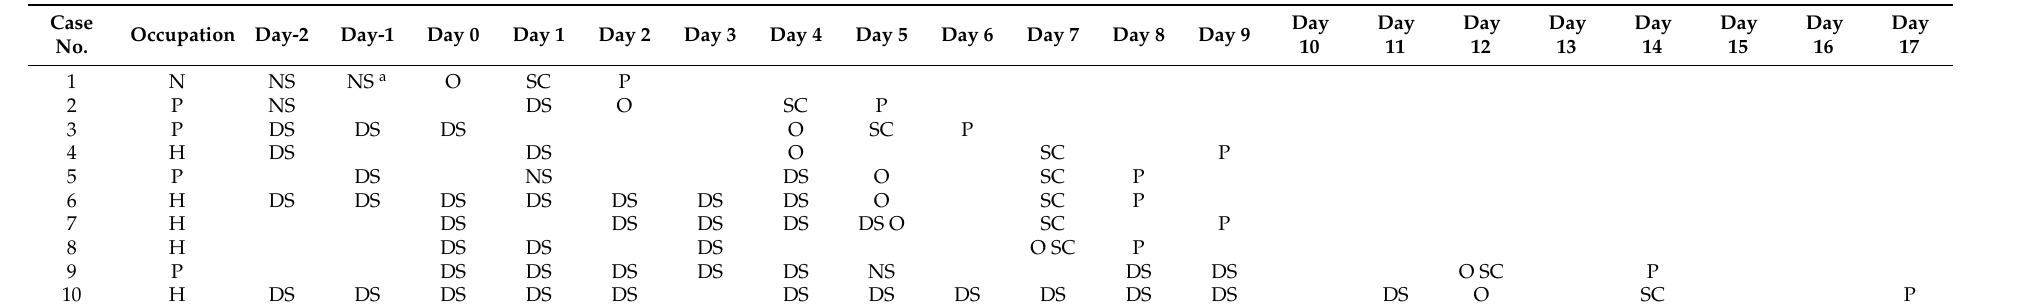
Table 3. Line list of SARS-CoV-2-positive individuals among the staff of the accommodation